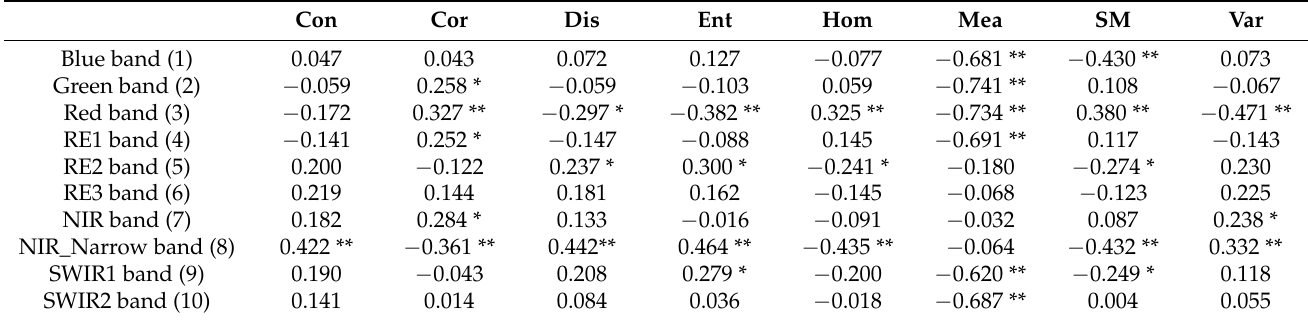
Table 9. Correlation coefficient matrix for texture feature and CC in each band.